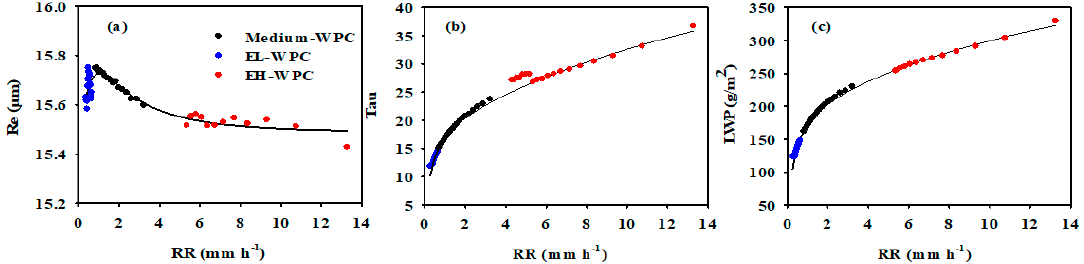
Figure 7. Relationship of RR with ( a ) Re (cloud effective radius), ( b ) Tau (cloud optical depth) and ( c ) LWP, for EL-WPC (blue points), EH-WPC (red points) and medium (medium-WPC) (all except EL-WPC and EH-WPC, black points) warm precipitating cloud.